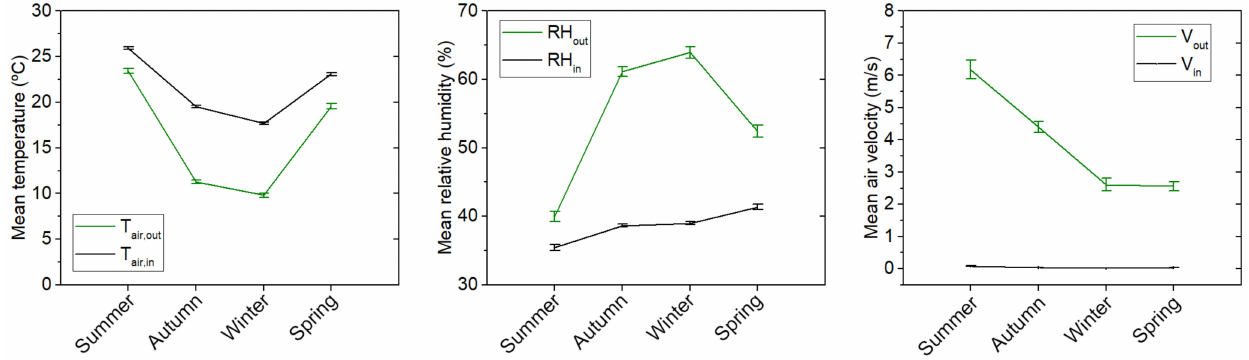
Figure 1. Variation of the indoor and outdoor environmental parameters by season.